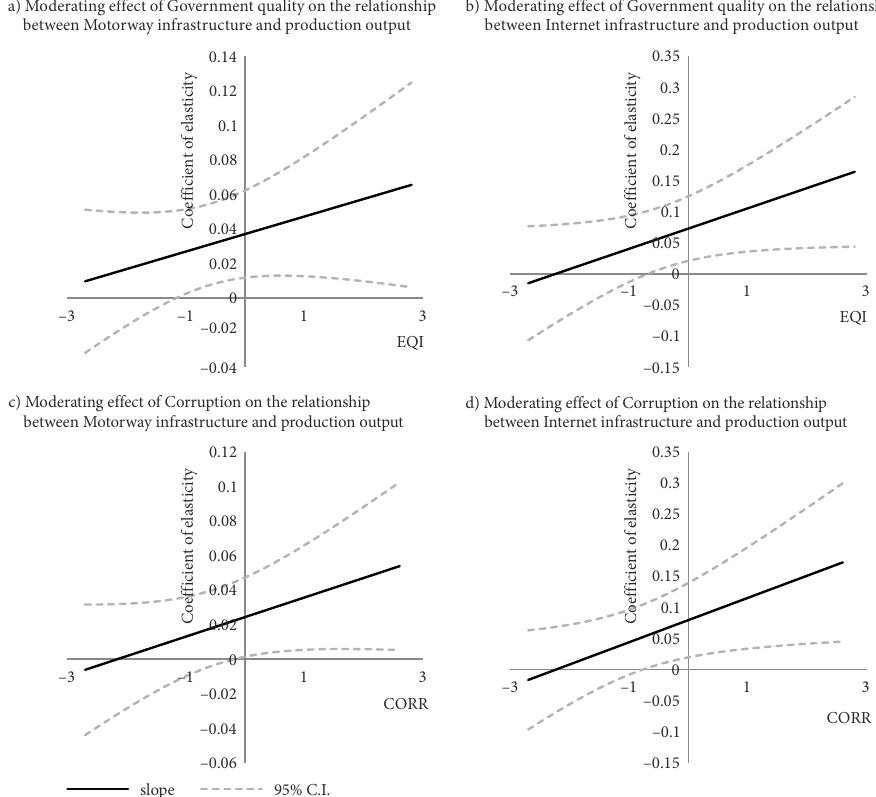
Figure 1. Moderating effect of institutions on the relationship between infrastructure and production output